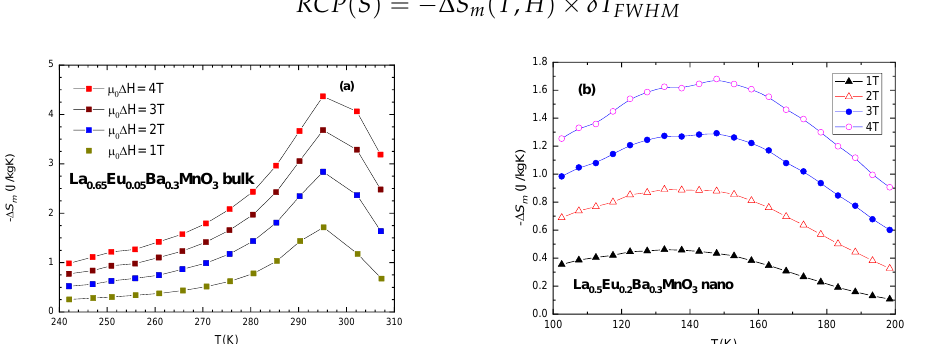
Figure 10. Magnetic entropy change vs. temperature for selected samples: ( a ) x = 0.05 bulk and ( b ) x = 0.2 nanocrystalline